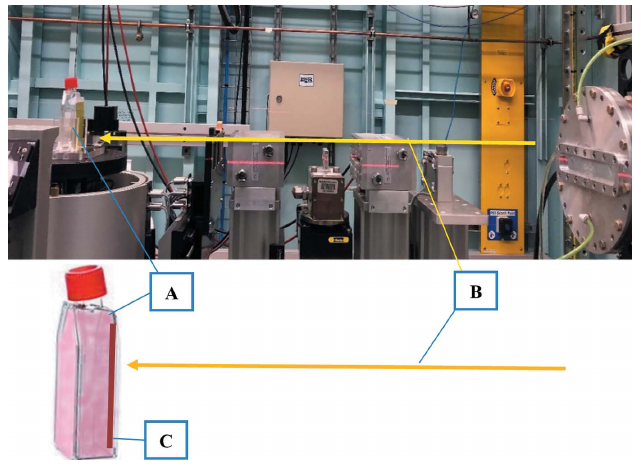
Figure 1 Setup for irradiating the cell samples with kilovoltage SR